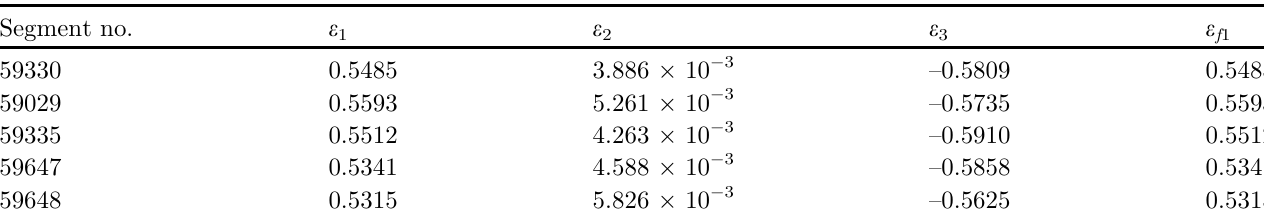
Table 3. Effective strain of the dangerous cross-section segments on the seal ring during fi llet contact. Segment no.